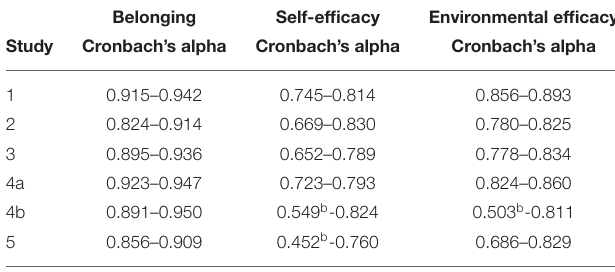
TABLE 3 | Cronbach’s alpha value ranges a across all